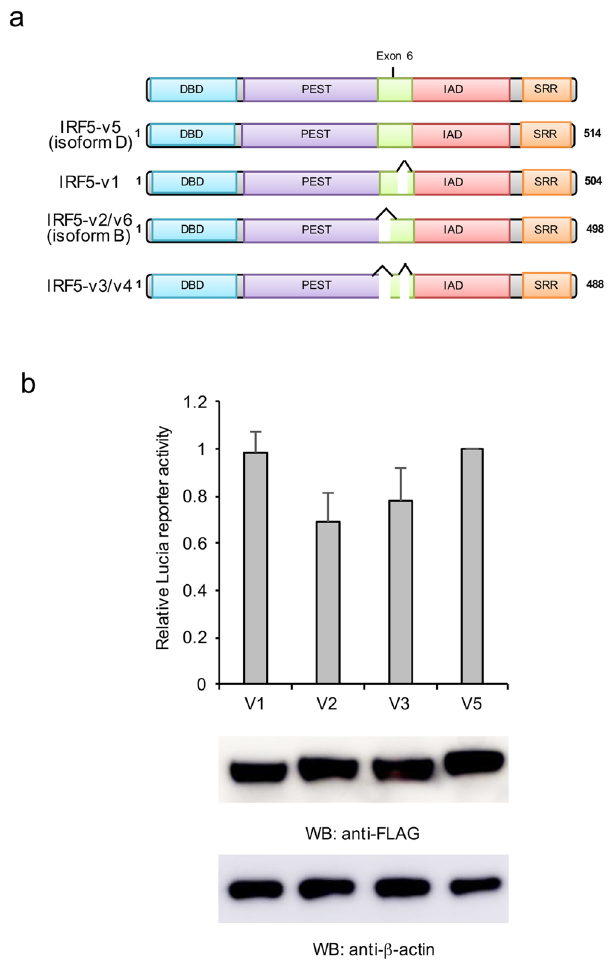
Figure 1. IRF5 variants activate IFN reporter. (a ) A schematic of different IRF5 isoforms. DBD, DNA binding domain; PEST, region rich in proline (P), glutamic acid (E), serine (S) and threonine (T) residues; IAD, IRF association domain; SRR, Serine-Rich Region. “ ^” represents deleted regions. ( b ) IRF5 isoforms or mutants were transfected with Lucia reporter and TLR7 into HEK293 cells. After 48 hr, cells were mock treated or stimulated with 10 μ g/ml R848 for 16 hr. Then cells were lysed and luciferase activities were examined. All experiments were repeated three times and two-tailed student’s t -test was performed. The protein expression levels were determined by Western